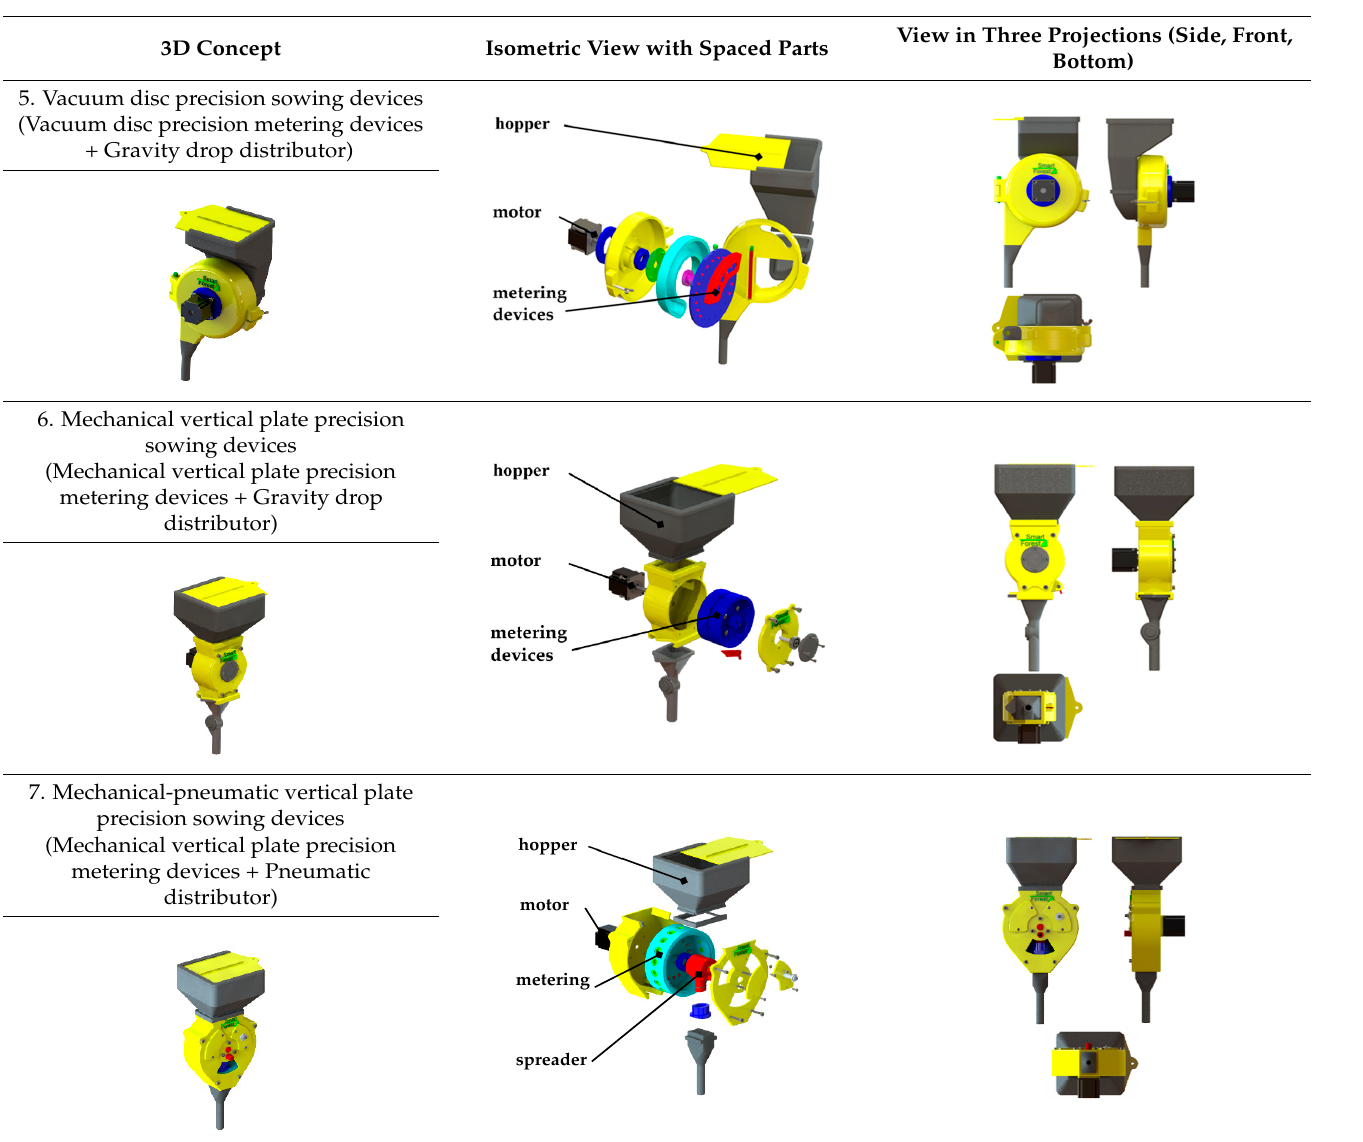
Table 2. Sowing device for precision Table 2. Sowing device for precision sowing. Table 2. Sowing device for precision sowing. Table 2. Sowing device for precision sowing. Table 2. Sowing device for precision sowing. Table 2. Sowing device for precision sowing. Table 2. Sowing device for precision sowing.